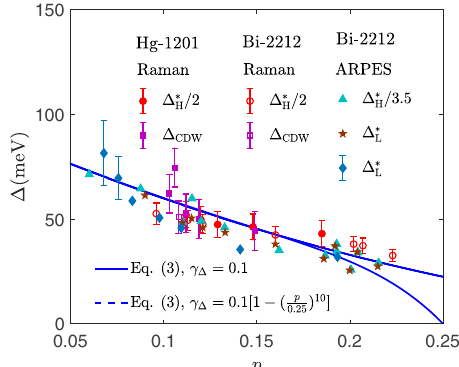
Fig. 2 Doping ( p ) dependence of various gap energy scales ( Δ ). The symbols represent the low-( Δ (cid:2) ) and high-( Δ (cid:2) ) energy scales of the L H pseudogap and the charge density wave (CDW) gap ( Δ CDW ) of Hg-1201 and Bi-2212 determined from the Raman response 15 and the angle-resolved photoemission spectroscopy (ARPES) data 35,42 . The vertical errors are extracted from the previous measurements 15,35,42 . The solid blue line represents the prediction from Eq. (3) with the scattering parameter γ Δ = 0.1 and the effective mass m (cid:2) = 2.45 m m e is the electron mass), a e ( linear model Q CDW = 0.343 − 0.699 p of the CDW vector and the in-plane lattice constant a 0 = 3.89 Å for Hg-1201 94 . The dashed blue line includes a quick decay of the CDW amplitude near the pseudogap quantum critical point. The root mean squared error for solid and dashed lines are both 6 meV.